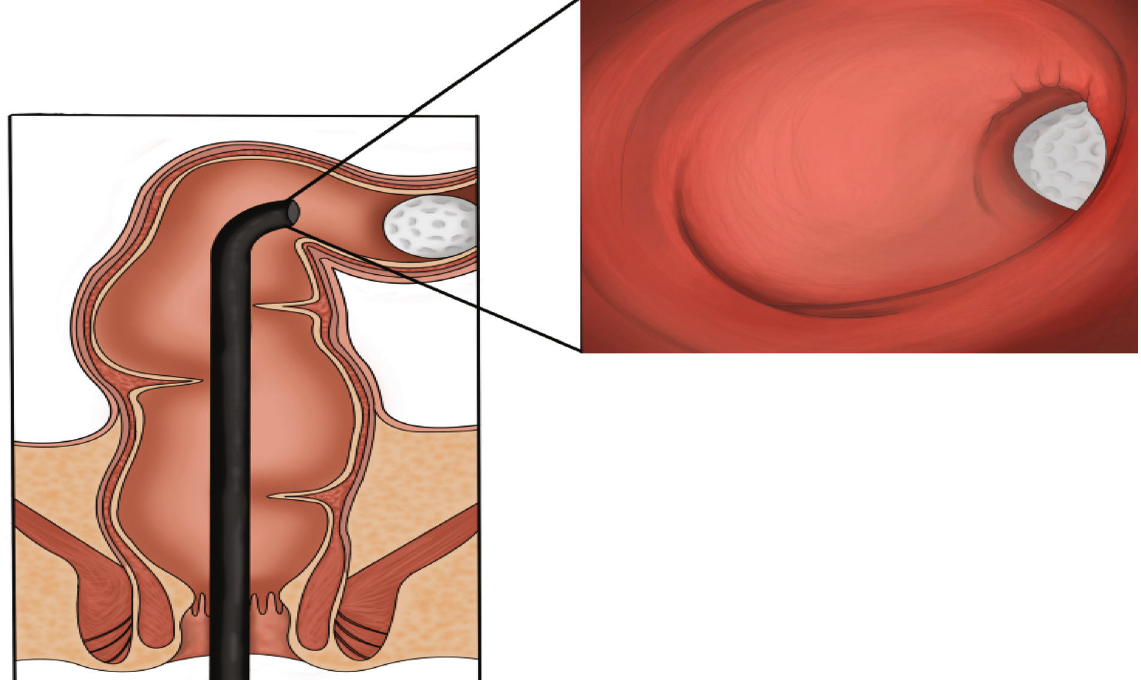
Figure 2: A graphic illustration of the golf ball around the rectosigmoid junction (Tymianski, 2022).